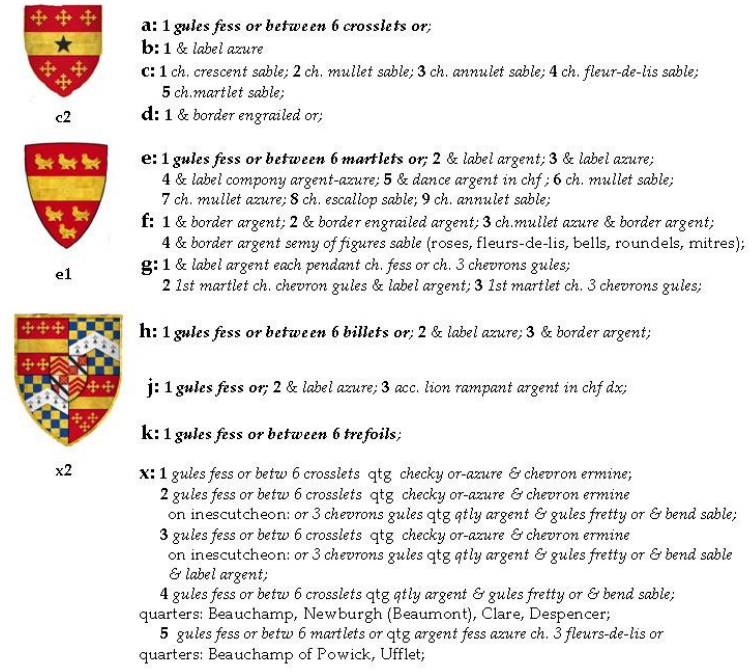
Figure 1. Survey of the arms used by or assigned to one or more Beauchamps.